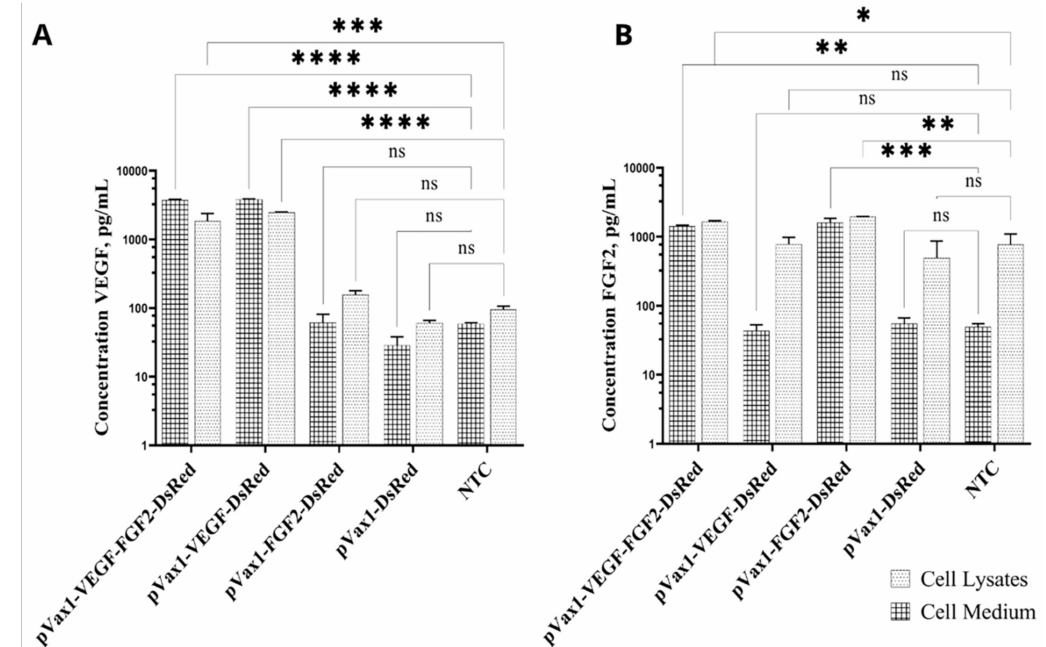
Figure 3. Analysis of VEGF and FGF2 concentrations in HEK293T cells transfected with obtained plasmid constructions. A total of 2.5 × 10 5 were seeded per well in a 12-well plate, and transfections were conducted after letting the cells adhere overnight. ( A ) VEGF concentration in supernatants and cell lysates of modified cells (pVax1-VEGF-FGF2-DsRed, pVax1-VEGF-DsRed, pVax1- FGF2-DsRed, pVax1-DsRed) and non-transfected controls (NTC); ( B ) FGF2 concentration in supernatants and cell lysates of modified cells (pVax1-VEGF-FGF2-DsRed, pVax1-VEGF-DsRed, pVax1- FGF2-DsRed, pVax1- DsRed) and non-transfected controls (NTC). Data presented as average ± s.e. of three independent repeats in independent samples, statistically significant differences * p < 0.05; ** p < 0.01; *** p < 0.0001, **** p < 0.0001;